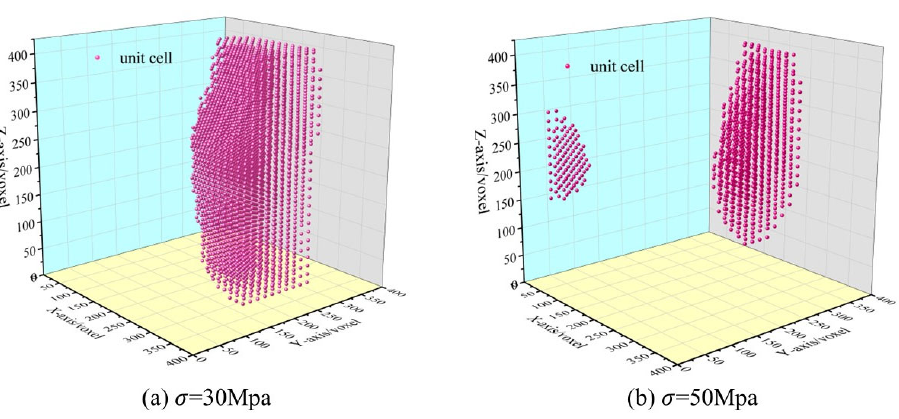
Figure 17. Space distribution of high-magnitude strains units under di ff erent stress stages.